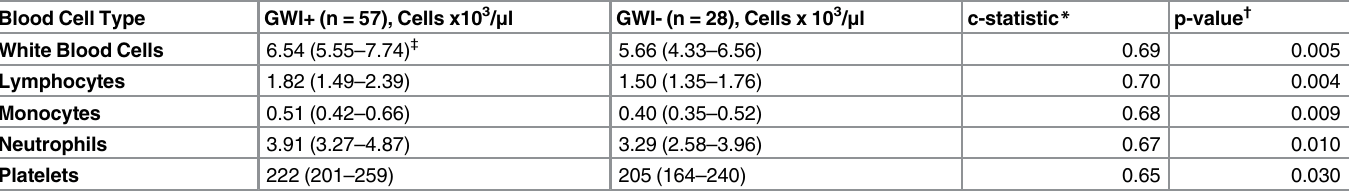
Table 3. Blood Cell Counts for GWI+ and GWI- Veterans.